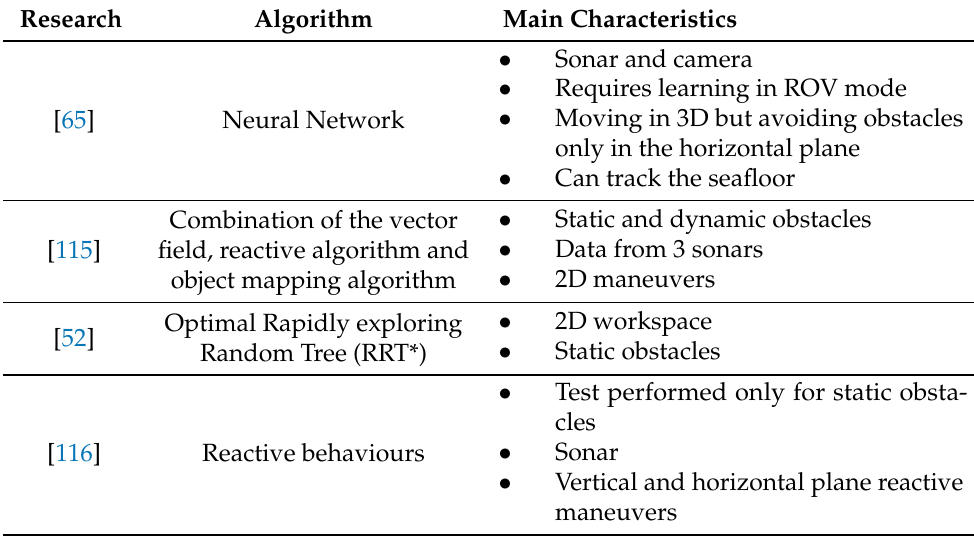
Table 5. List of algorithms in real applications between